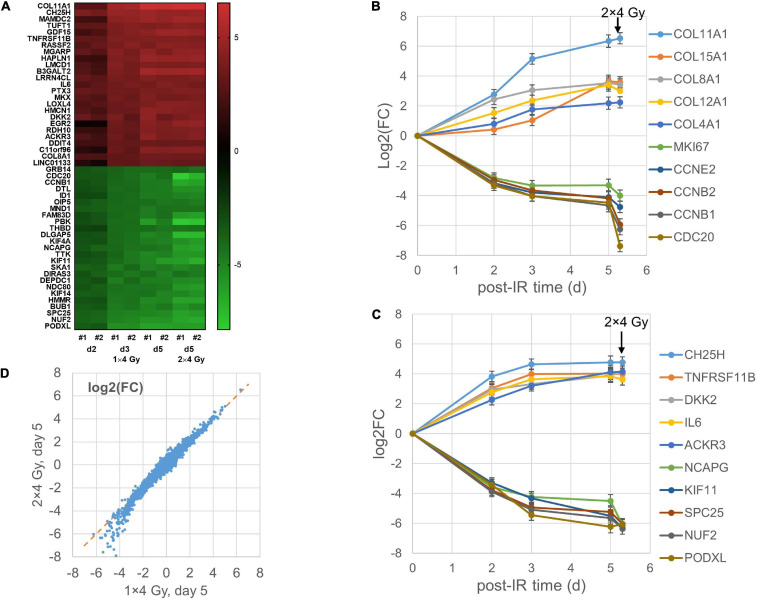
Heat map of top 25 up- and down-regulated genes for the MA protocol in independent replicate microarray experiments #1–2 (A). Examples of log2 fold changes [log2(FC)] in expression of differentially regulated genes 2–5 days after a single dose of 4 Gy or 5 days after the first of two fractions of 4 Gy; mean values and error bars (95% confidence intervals) from the two experiments are shown (B,C). Correlation between mean log2(FC) values after 2 × 4 Gy and 1 × 4 Gy (D) with RNA isolation on day 5 after the first dose.